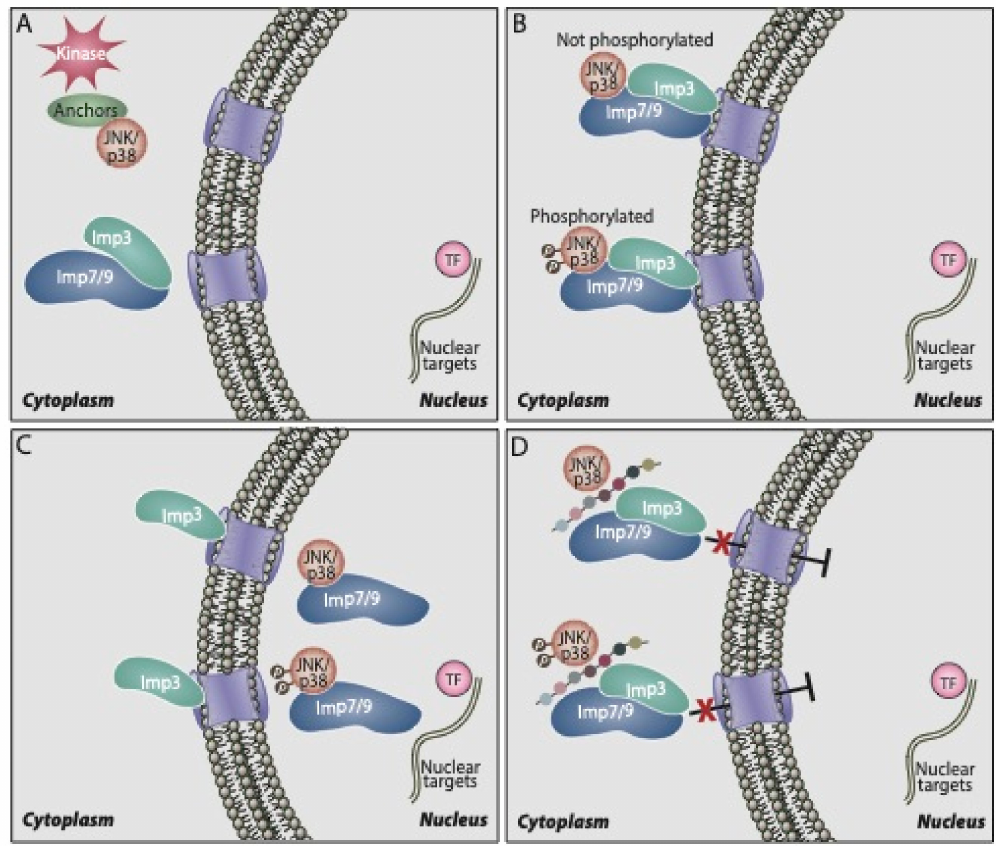
Figure 1. Scheme showing the mechanism of nuclear p38 α / β translocation and its inhibition by the PERY peptide. A . p38 α / β are localized in the cytoplasm of resting cells and some of the molecules are phosphorylated upon stimulation. B . Phosphorylated or non-phosphorylated p38 α / β bind to a dimer of Imp7 / 3 or Imp9 / 3, which escort them to the nuclear pores. C . Imp3 stays outside, while Imp7 or Imp9 escort the p38 α / β through the nuclear pores, to the nucleus, where they dissociate from the importins, and are free to phosphorylate their substrates. D . Translocation of the kinases to the nucleus can be inhibited using the inhibitory PERY peptide that was synthesized according to the sequence of the p38 α –Imp binding site as described in the